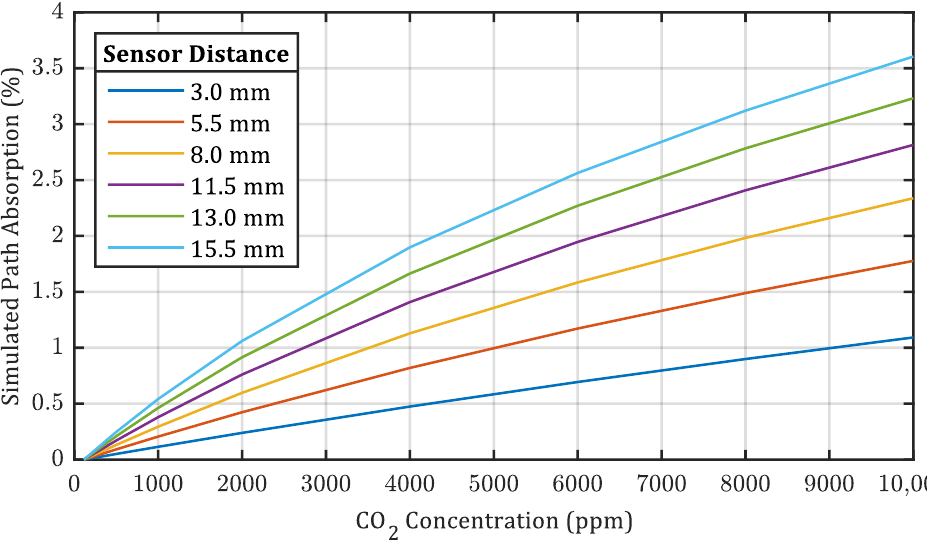
Figure A3. Additional absorption, simulated with HITRAN, for applied CO 2 concentrations in the sensor path, normalized to the absorption of each absorption path at the measurements’ lowest CO 2 concentration. Only the direct distance was calculated. Reflections inside the reflector tube were neglected.